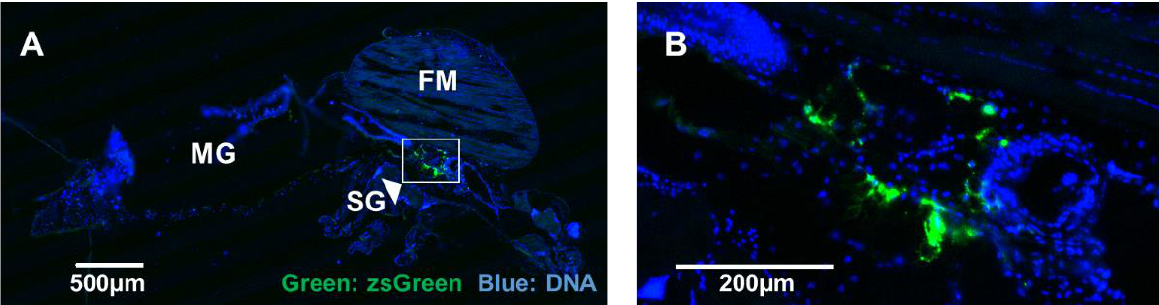
Figure 5. Microinjection of Aedes aegypti with BinJV zsGreen reporter virus. ( A ) zsGreen signal (green) in a representative frozen section from a seven-days post-infected mosquito visualised using fluo- rescence microscopy. DNA was stained to reveal other tissues for orientation. Midguts (MG), flight muscle (FM), and salivary glands (SG) are indicated. ( B ) Magnified region of high signal around the SG. Scale bars are indicated on the figures.